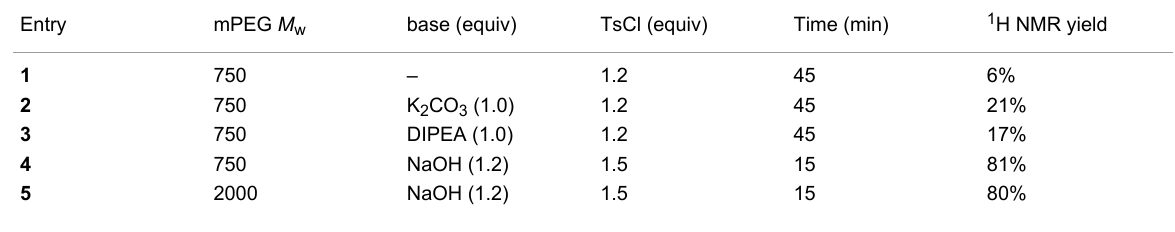
Table 1: Surveyed reactions for mechanochemical derivatization of mPEG with tosylate functionality. TsCl = p -toluenesulfonyl chloride; CEA = chloroethylamine·HCl; M w = molecular weight. All reactions were ball-milled at an operating frequency of 30 Hz.